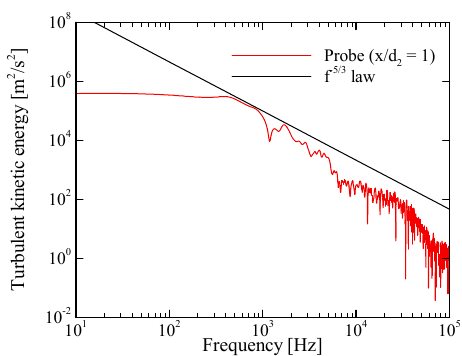
Figure 5. Frequency spectrum of turbulent kinetic energy (TKE) at a probe point ( x / d 2 = 1). Abscissa and ordinate axes are expressed in log scale, respectively.